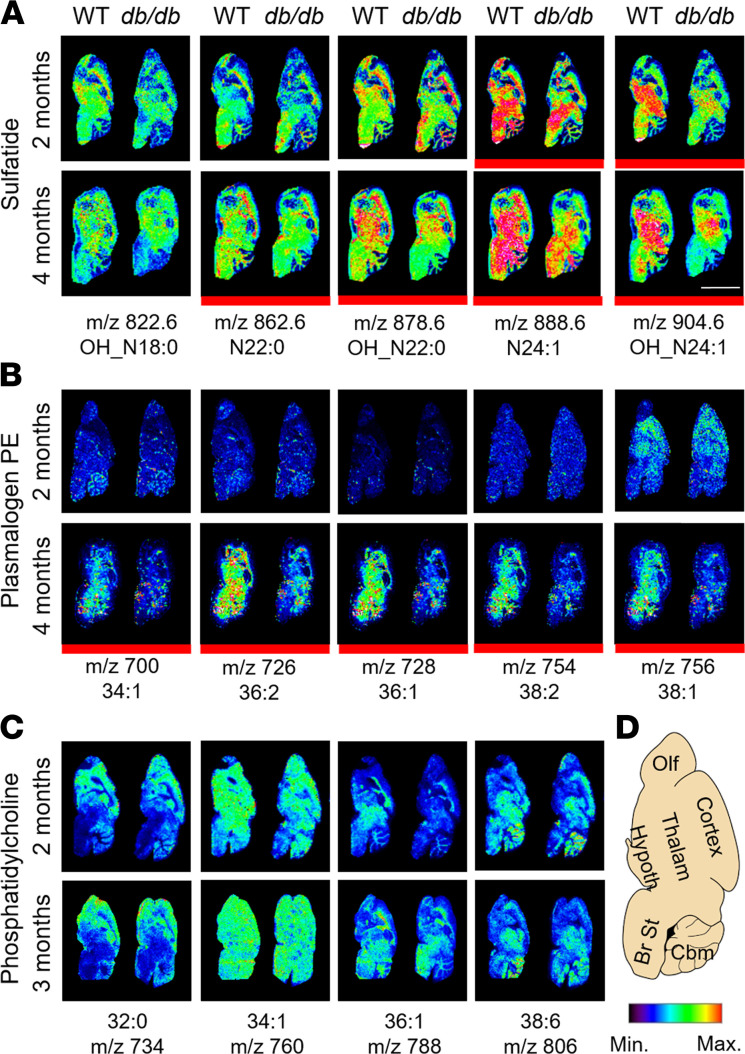
Depletion of myelin-enriched lipids in the brains of obese diabetic mice.Whole brains from 2- to 4-month-old WT and db/db male mice were dissected, frozen, and sectioned sagittally (10 μm). Representative MALDI mass spectrometry imaging (MSI) maps of major sulfatide (A), P PE (B), and phosphatidylcholine (PC) (C) molecular species from n = 2–3 male mice/genotype/time point, except for 3/4-month plasmalogen PE and PC, where only 1 mouse per genotype was assessed. Lipid molecular species that displayed evident and consistent genotype differences are highlighted by a red thick line below the image. MALDI MSI resolution: 150 μm; scale bar (white): 5 mm. (D) Mouse brain schematic. Olf, olfactory lobe; Thalam, thalamus; Hypoth, hypothalamus; Br St, brainstem; Cbm, cerebellum.